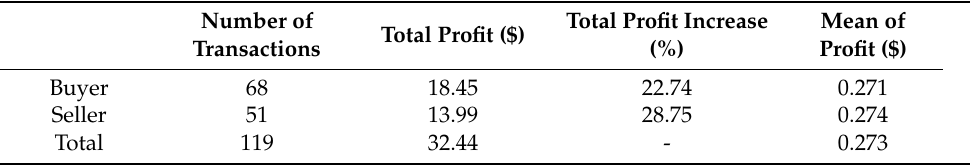
Table 2. Result of the double auction mechanism with optimal bidding price.